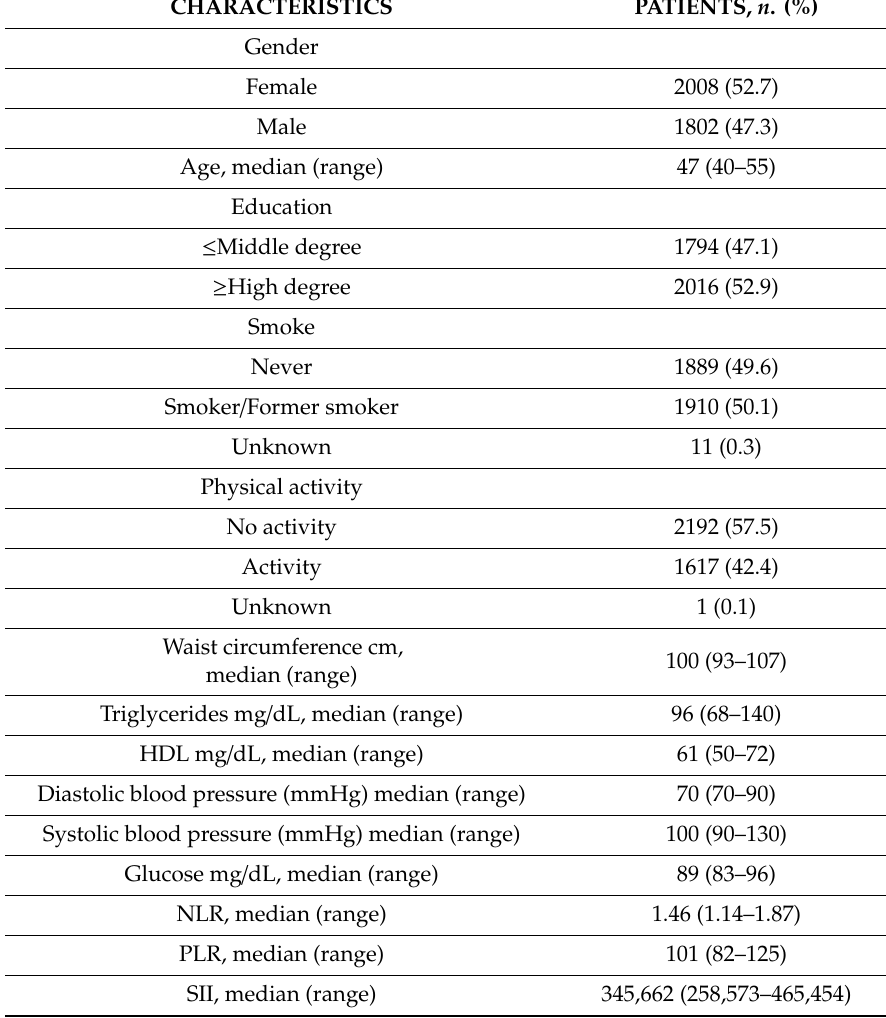
Table 1. Main characteristics of the population study.